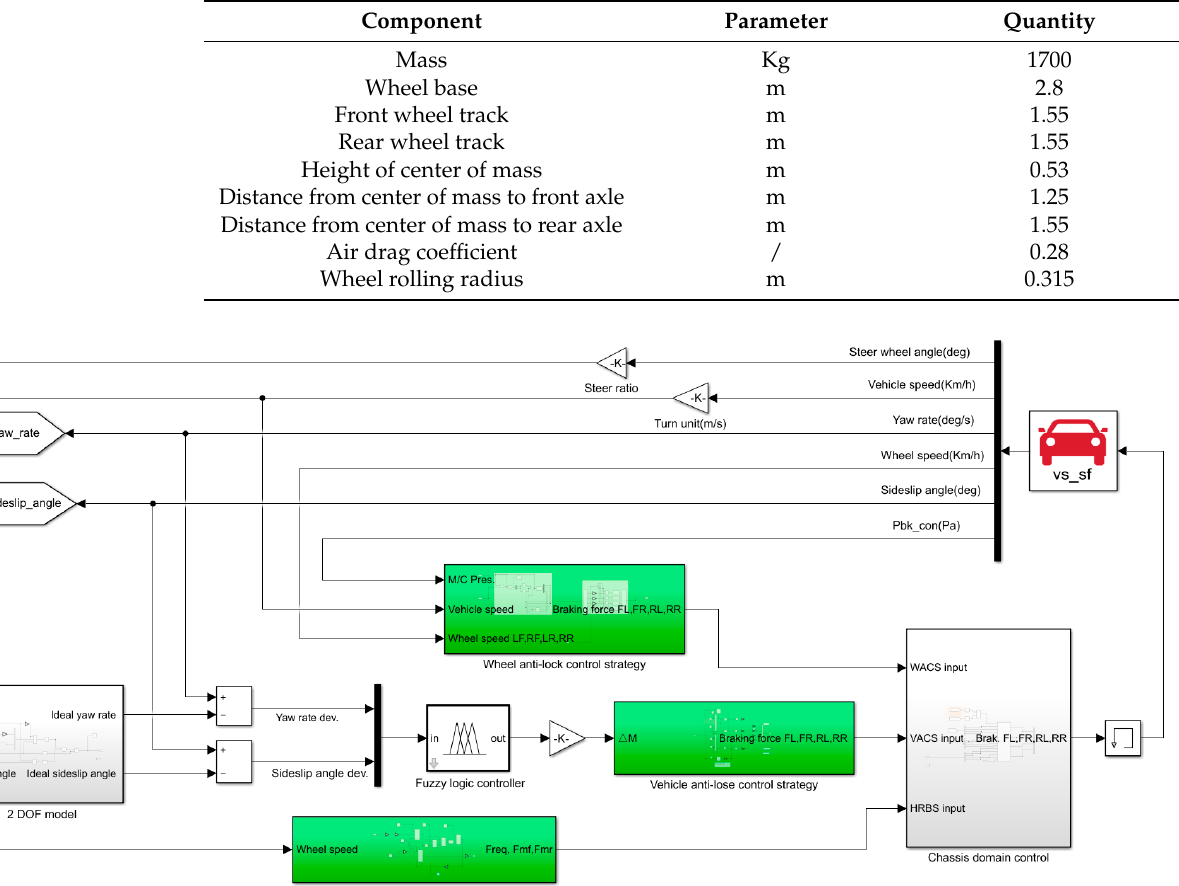
Table 2. The parameters of the vehicle.